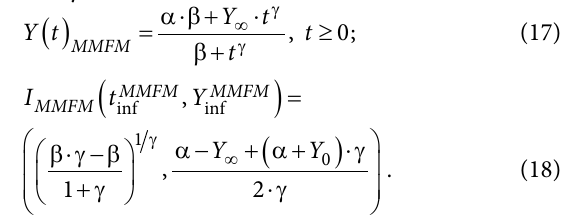
Table 3. China’s LNG import and consumption